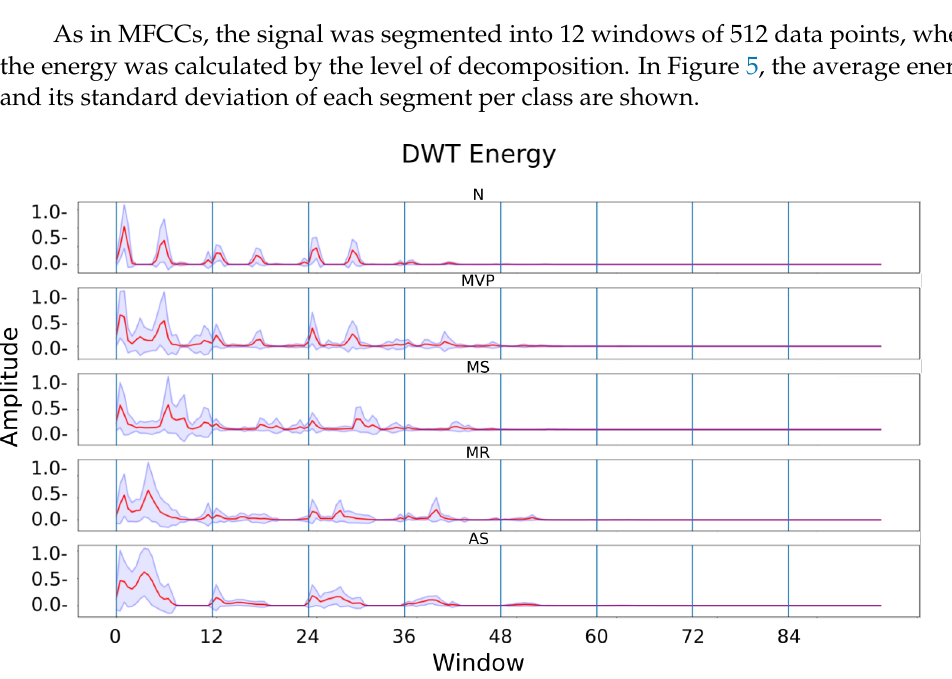
Figure 5. Energy calculation: The red line and the blue shadows are the averages and their standard deviation for each record per class, respectively. The vertical lines separate the decomposition levels in the following order: Approximation 7 (A7), Detail 7 (D7), D6, D5, D4, D3, D2,